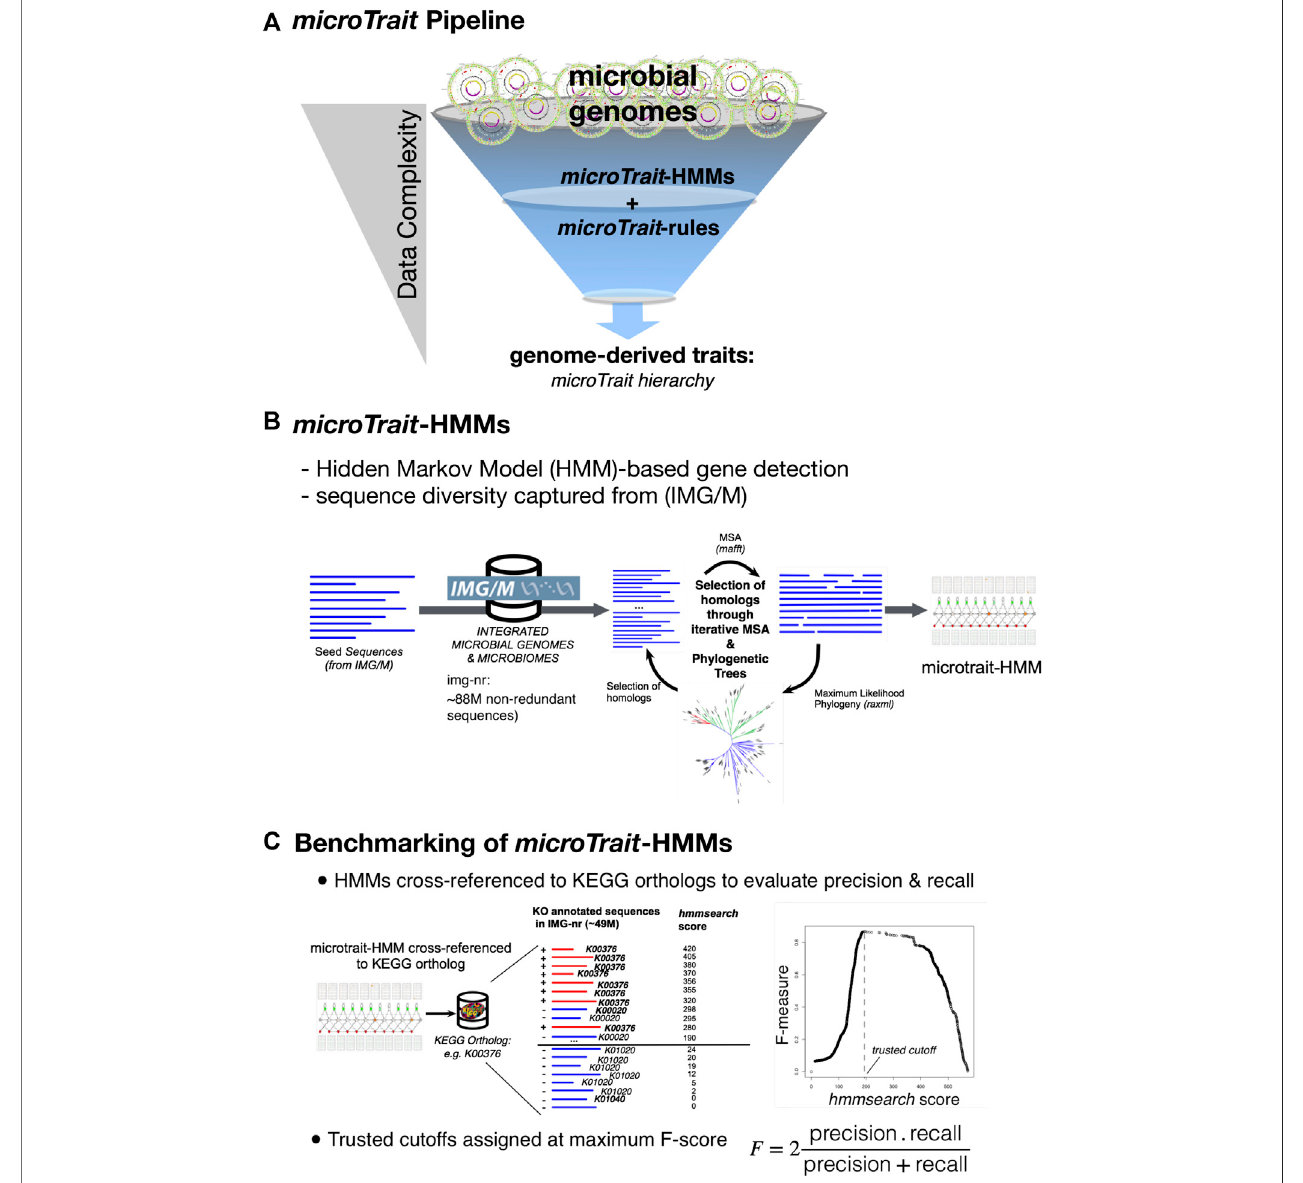
FIGURE 2 | Overview of microTrait . (A) microTrait pipeline consists of a library of gene-level Hidden Markov Models ( microTrait -HMMs) for detection of genome features and logical rules ( microTrait -rules) that map these features to traits. The output from the pipeline are trait matrices (genomes × traits) at different granularities corresponding the levels of the microTrait hierarchy. (B) Work fl ow for construction of microTrait -HMMs. Each HMM models the diversity of sequences from IMG/M at gene-level. (C) Benchmarking of microTrait -HMMs. The trusted cutoffs for microTrait -HMMs were determined through cross-references to KEGG orthologs (whenever